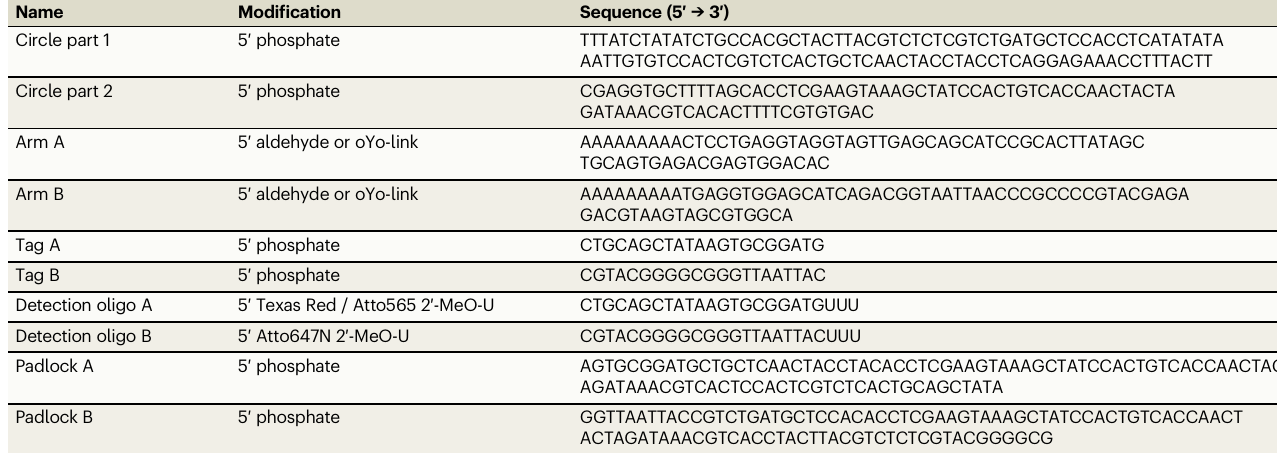
Table 1 | DNA design for